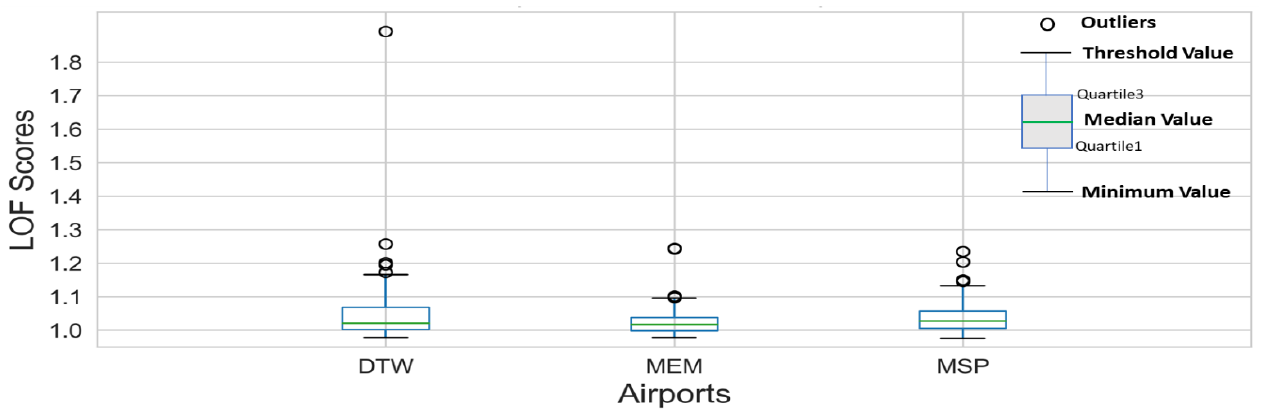
Figure 11. Boxplots for 3 different airports showing outliers using hybrid LOF – Tukey method.